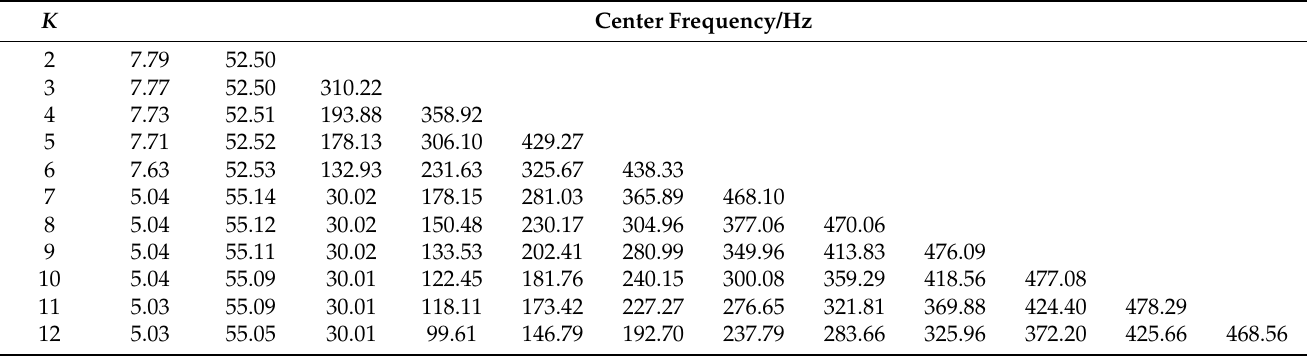
Table 1. The mode number corresponding to the distribution of IMF’s center frequency by VMD.